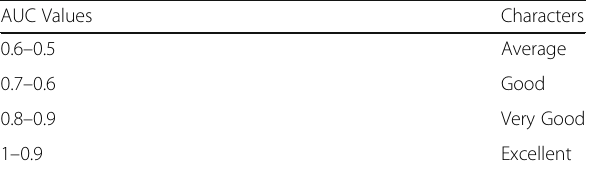
Table 7 Characteristics of AUC of ROC curve (Yesilnacar 2005) AUC